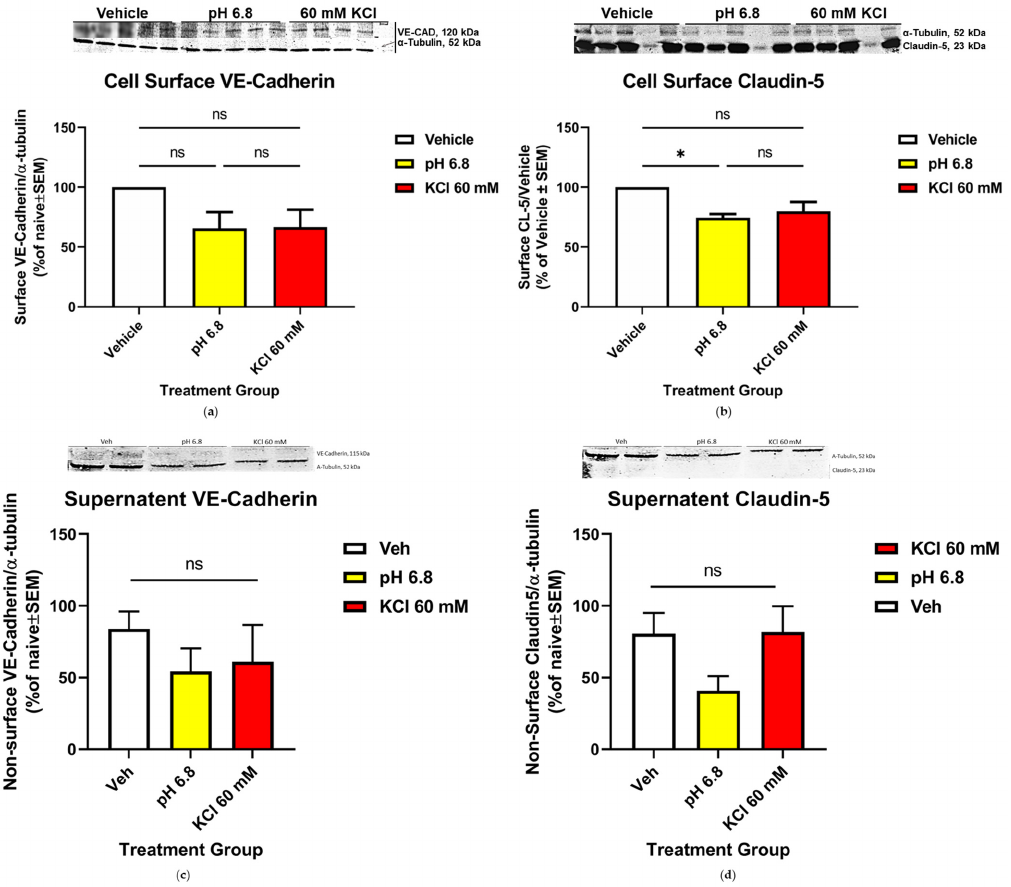
Figure 3. VE-CAD and CL-5 surface localization following KCl and acidified pH exposure in vitro. Biotynylation pulldown quantification plots of ( a ) VE-CAD and ( b ) CL-5 following 60 mM KCl and acidified pH insult. CL-5 detection was significantly increased following acidified pH exposure, while VE-CAD detection was not significantly affected, suggesting a direct pH-mediated mechanism on CL-5 localization, CL-5: Veh vs. 60 mM KCl: mean difference = 20.16, 95% CI ( − 0.8883, 41.21), p = 0.0587, n1 = 3, n2 = 3; Veh vs. pH = 6.8: mean difference = 25.49, 95% CI (4.444, 46.54), * p = 0.0231, n1 = 3, n2 = 3; analyzed by one-way ANOVA with Tukey’s multiple comparison test post hoc F(2,6) = 7.684, p = 0.0221. VE-CAD: Veh vs. 60 mM KCl: mean difference = 33.37, 95% CI ( − 16.46, 83.20), p = 0.1801, ns = no significance, n1 = 3, n2 = 3; Veh vs. pH = 6.8: mean difference = 34.35, 95% CI ( − 15.48, 84.17), p = 0.1668, n1 = 3, n2 = 3. Analyzed by one-way ANOVA with Tukey’s multiple comparison test post hoc F(2,6) = 2.900, p = 1315). No significant detection of VE-CAD ( c ) or CL-5 ( d ) was observed in supernatant collected during biotynylation (VE-CAD: Veh vs. 60 mM KCl: mean difference = 10.19, 95% CI ( − 153.7, 174.1), p = 0.9934, ns = no significance, n1 = 2, n2 = 2; Veh vs. pH = 6.8: mean difference = 25.14, 95% CI ( − 138.8, 189.1), p = 0.9191, ns = no significance. Analyzed by one-way ANOVA with Tukey’s multiple comparison test post hoc, F(3,4) = 0.1315, p = 0.9364; D, CL-5: Veh vs. 60 mM KCl: mean difference = 7.446, 95% CI ( − 227.8, 242.7), p = 0.9991, ns = no significance, n1 = 2, n2 = 2; Veh vs. pH = 6.8: mean difference = 65.03, 95% CI ( − 170.2, 300.2), p = >0.6957, ns = no significance. Analyzed by one-way ANOVA with Tukey’s multiple comparison test post hoc, F(3,4) = 1.366; p = 0.3732).